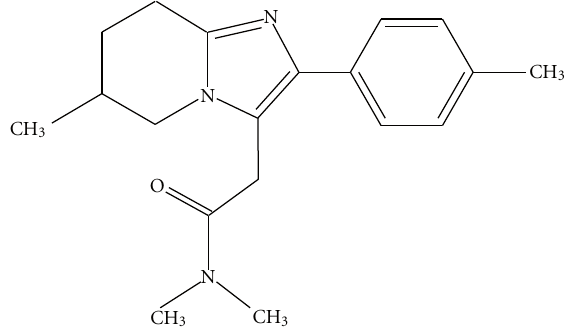
F 1: Structure of zolpidem.